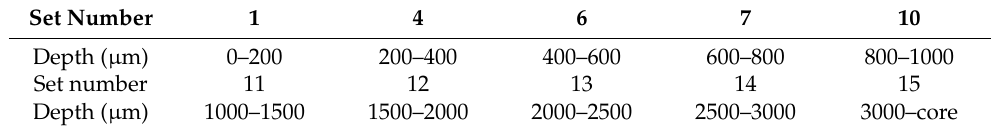
Table 2. Sets’ distribution.